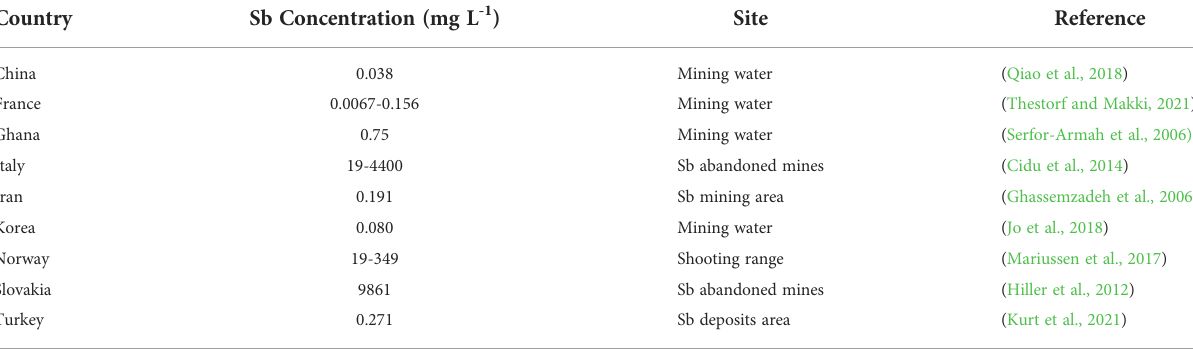
TABLE 2 Concentration Sb of in water bodies of different